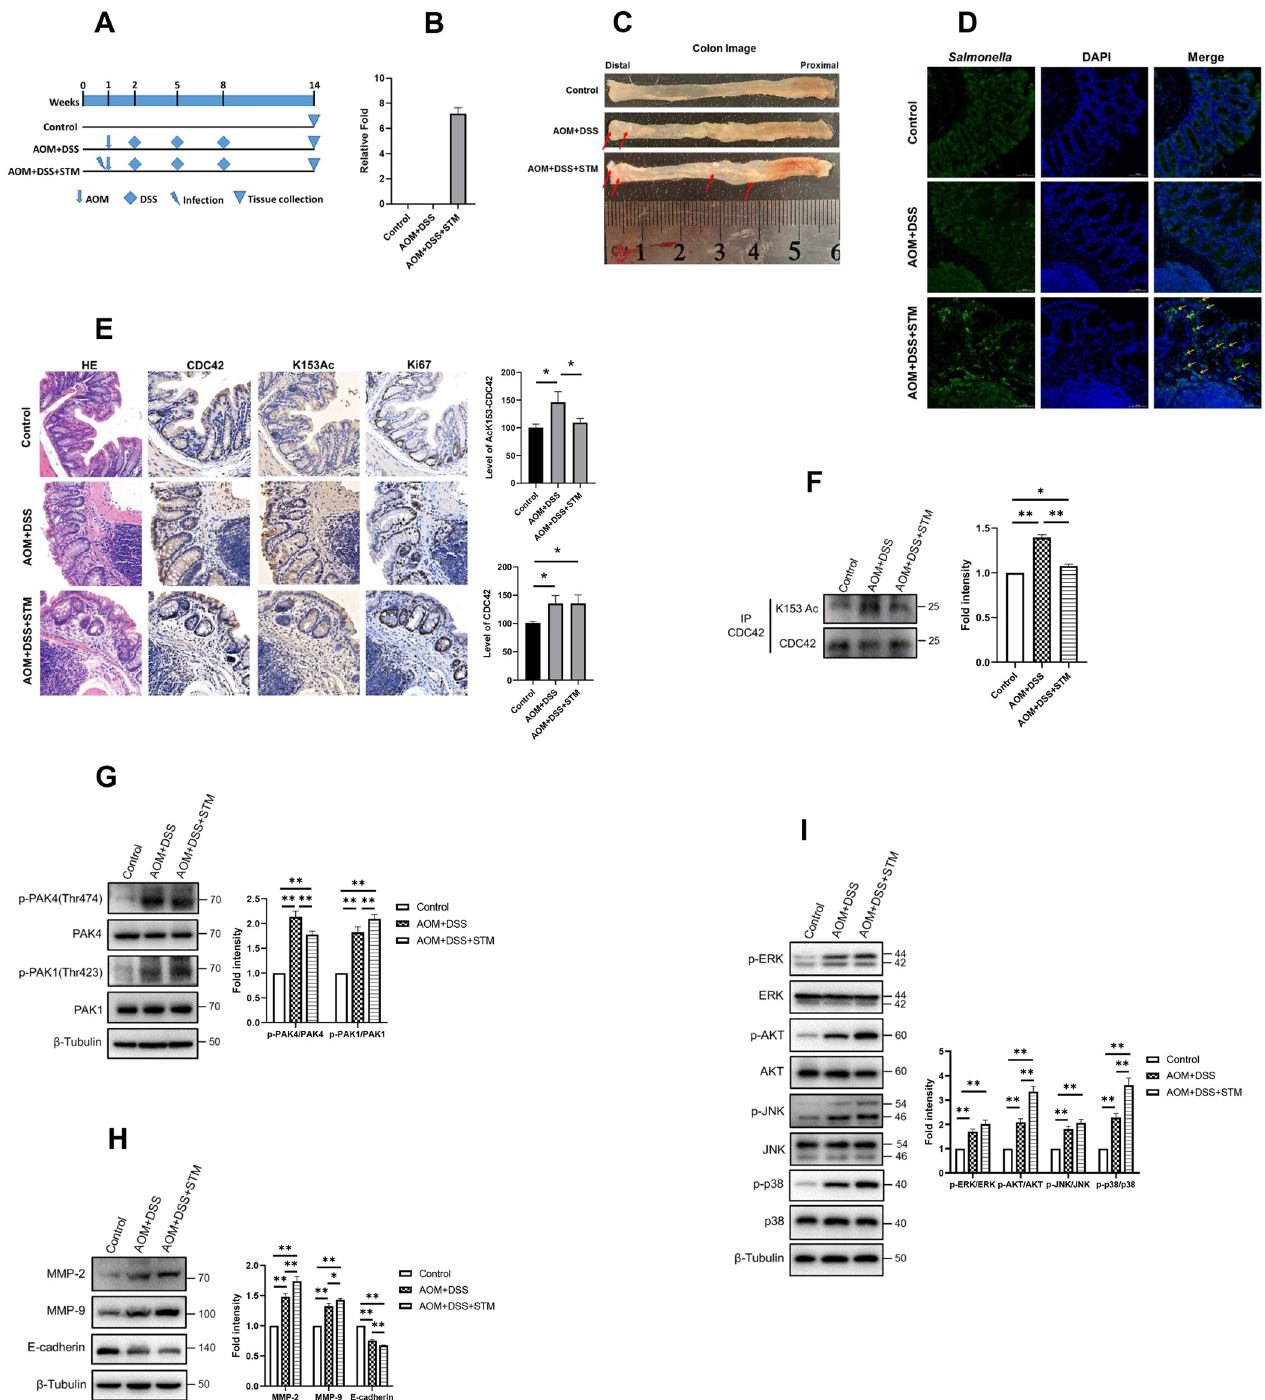
Fig 7. K153 acetylation is down-regulated in CRCs. (A) Scheme of the experimental design. Arrow symbols indicate azoxymethane (AOM), 10mg/kg body weight, administered through intraperitoneal injection. The lightning symbol indicates that mice were infected with Salmonella through a blunt gavage needle. Rhombus symbols indicate the administration of 1.5% dextran sodium sulfate (DSS) in drinking water. Triangle symbols indicate that mice were sacrificed, and their colorectal tissues were collected. (B) Fecal Salmonella was detected by PCR with Salmonella -specific primers after 14 weeks post-infection. (C) Colonic tumors in situ . Representative colons from the indicated groups 14 weeks after Salmonella infection. Tumors are indicated by red arrows. (D) Localization of Salmonella in the tissues of the indicated groups was assessed by immunofluorescence staining with anti- Salmonella -specific LPS antibodies. (E) Control mucosa and colonic tumors in each group were stained by hematoxylin-eosin (HE) staining, and the expression levels of CDC42, CDC42 K153 acetylated and